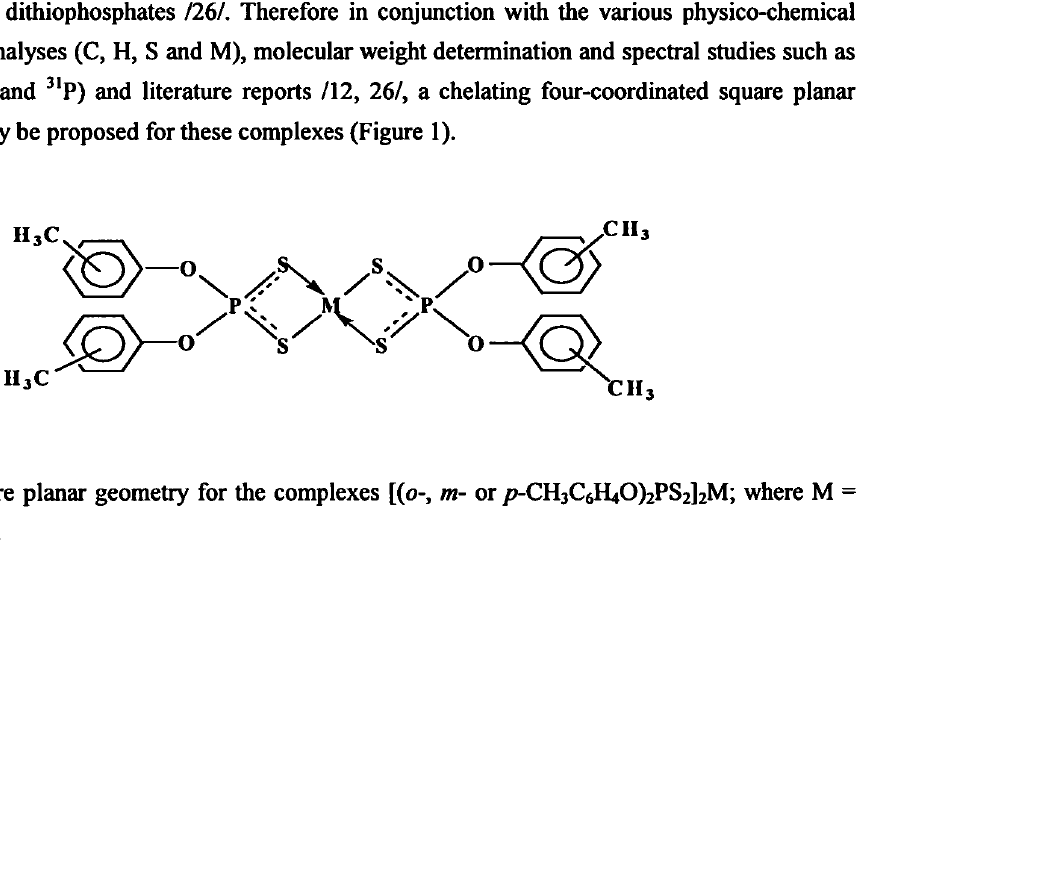
Fig. 1: Proposed square planar geometry for the complexes [(o-, m- or p-CH Zn, Cd and